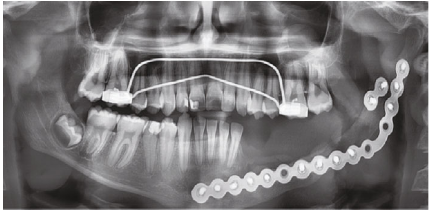
Figure 4: Postoperative view with the